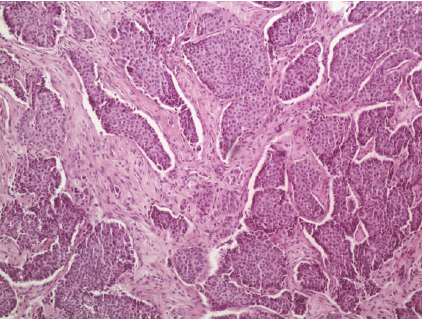
Figure 1: Lobules and cords of aggressive digital papillary adeno- carcinoma (H & E, original magnification 100x).